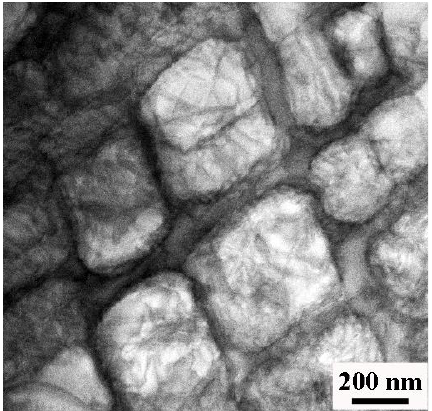
Figure 8. Dislocation configurations near fracture surfaces of tensile-ruptured DD9 alloy with LABs of 3.7°at 1100°C.